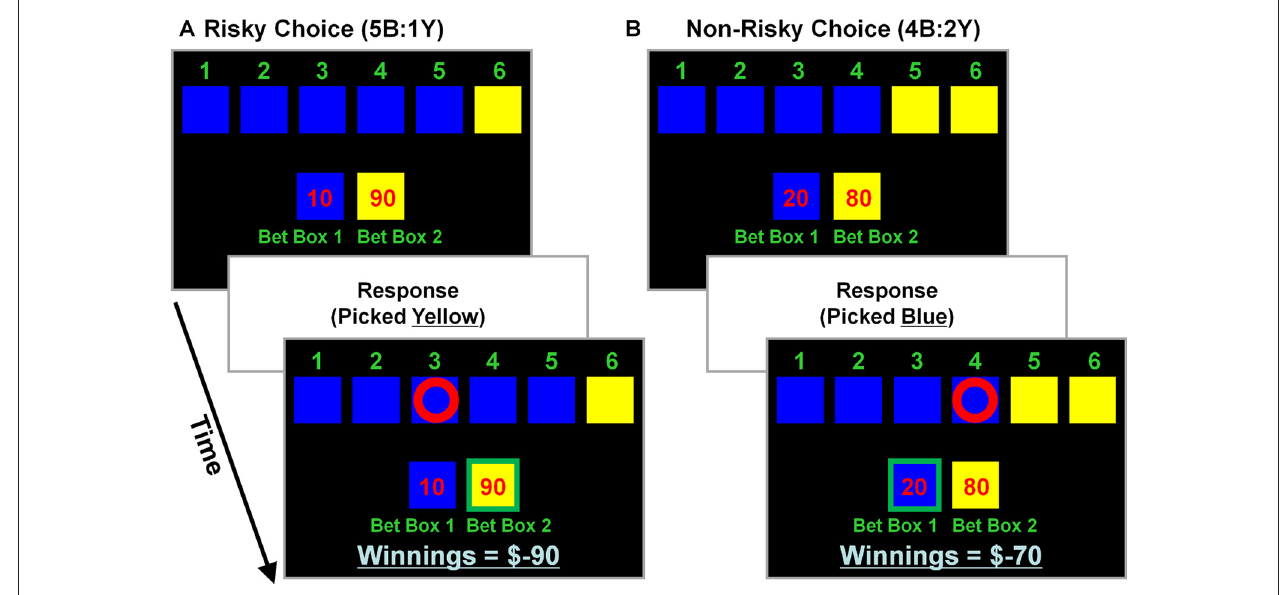
FIGURE 1 | Cambridge decision-making task (CDMT) schematic. Participants were instructed to maximize their accumulated point totals by choosing between one of two options (i.e., pick blue or yellow). Six colored boxes were displayed, in one of which was “hidden” a winning token. The ratio of colored boxes provided information on the odds of the blue (B) and yellow (Y) boxes containing the token (5B:1Y [16.6% chance in yellow], 4B:2Y [33.3% chance in yellow] and 3B:3Y [50% chance in yellow]). The “bet boxes” provided information on the number of points associated with each of the color options (blue:yellow; 10:90, 20:80, 30:70; 40:60, 50:50). Participants selected the color they anticipated contained the hidden token via a button press. After making a selection, feedback was presented, such that a correct selection resulted in the addition of the number of points at stake to the “winnings” total, whereas an incorrect selection resulted in the subtraction of the same amount. Larger rewards were associated with the yellow options which also were less likely to contain the hidden token (except during neutral risk trials [i.e., 3B:3Y]). A risky selection was operationalized as having chosen yellow in the 5B:1Y or 4B:2Y conditions, regardless of the points at stake. (A) Example of a risky selection. This trial involves 5 blue boxes and 1 yellow box (5B:1Y) with 10 points at stake associated with a blue selection and 90 points with yellow (10:90). In this example, picking yellow (a risky selection) was an incorrect choice that resulted in subtracting 90 points from the “winnings” total (initially 0 at task onset). (B) Example of a non-risky selection. This trial involves 4 blue and 2 yellow boxes (4B:2Y) with 20 points at stake associated with a blue selection and 80 points with yellow. In this example, picking blue (a non-risky selection) was a correct choice that resulted in adding 20 points to the winning total (was − 90 from the previous